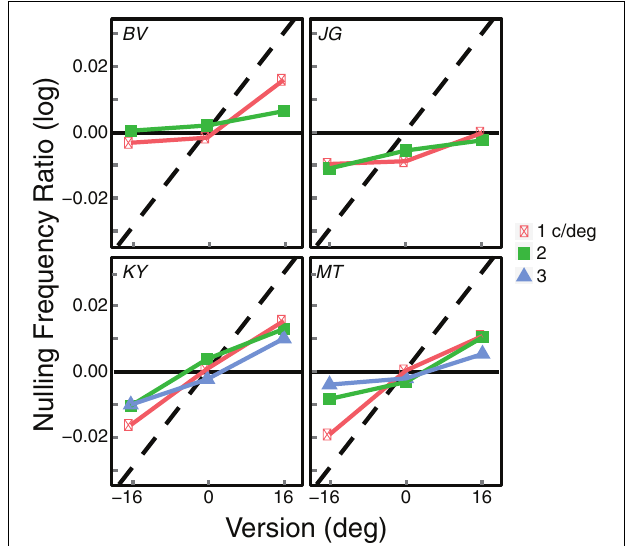
FIGURE 6 | Summary results from Experiment 2. Each panel shows the results from an individual observer. The logarithm of the average of the inter-ocular frequency ratios that produced visible blinds is plotted as a function of gaze direction. Different symbols represent the data from different average spatial frequencies. The black horizontal lines represent the predicted frequency ratios for seeing blinds based on disparity. The dashed diagonal lines represent the predictions for blinds perception based on slant; those predictions differ slightly across observers because of their differing inter-ocular distances.